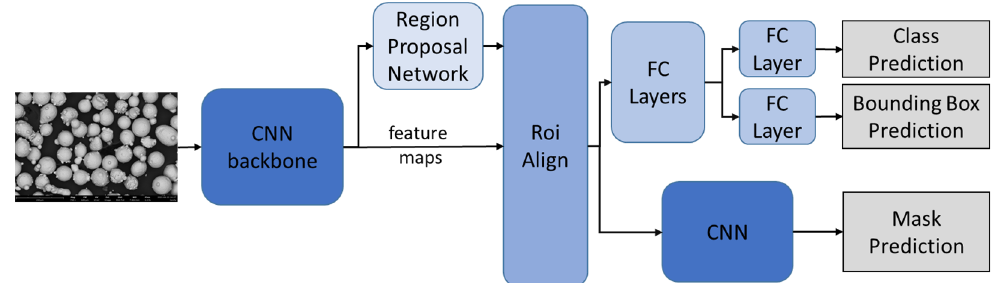
Figure 2. The mask R-CNN architecture; the information flows from left to right.